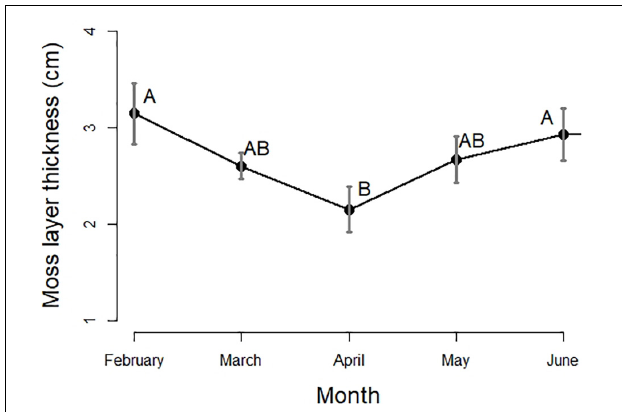
FIGURE 4 | Moss layer thickness variation throughout the dry season. Different letters indicate significant ( p < 0.05) differences among months.